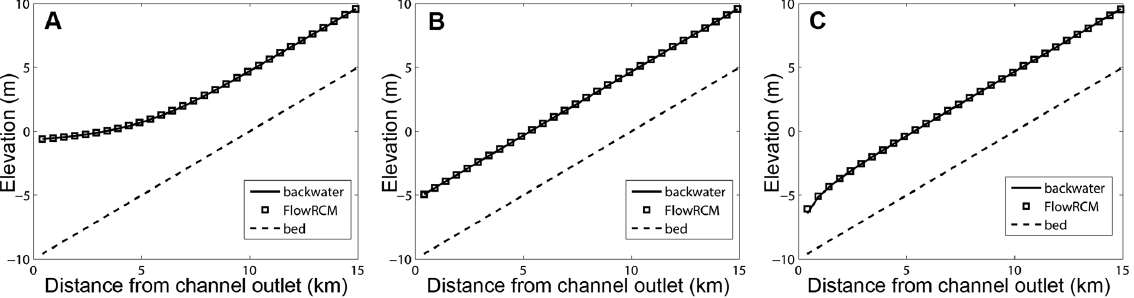
Figure 3. Results from test 1 (straight channel test). The water surface profile in the longitudinal direction calculated by FlowRCM (averaging the 2-D profile in the cross-stream direction) is compared to the numerical solution of the 1-D backwater equation in three scenarios: (a) M1 curve, (b) normal flow, and (c) M2 curve.